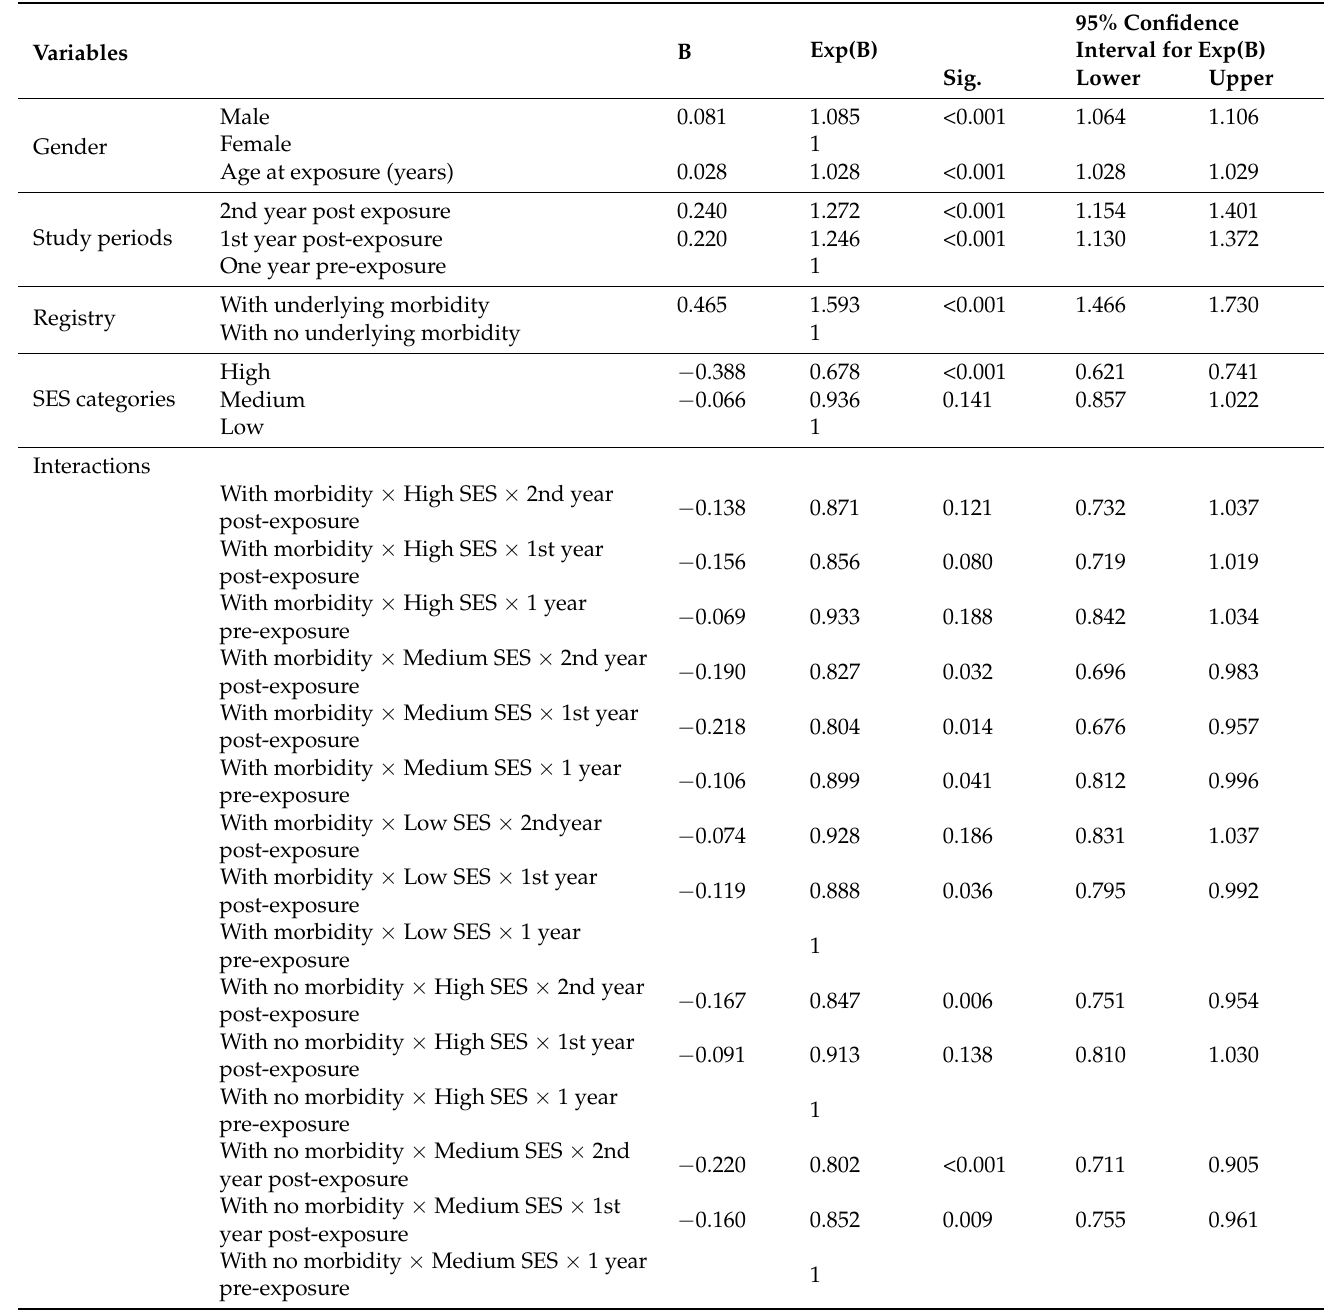
Table 3. Results of the final regression